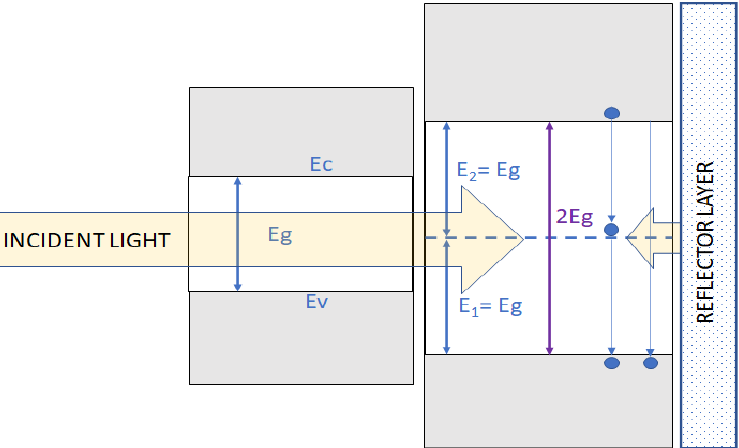
Figure 10. The concept of a down-converting luminescent concentrator with a back light reflector, based on the idea presented in [130].